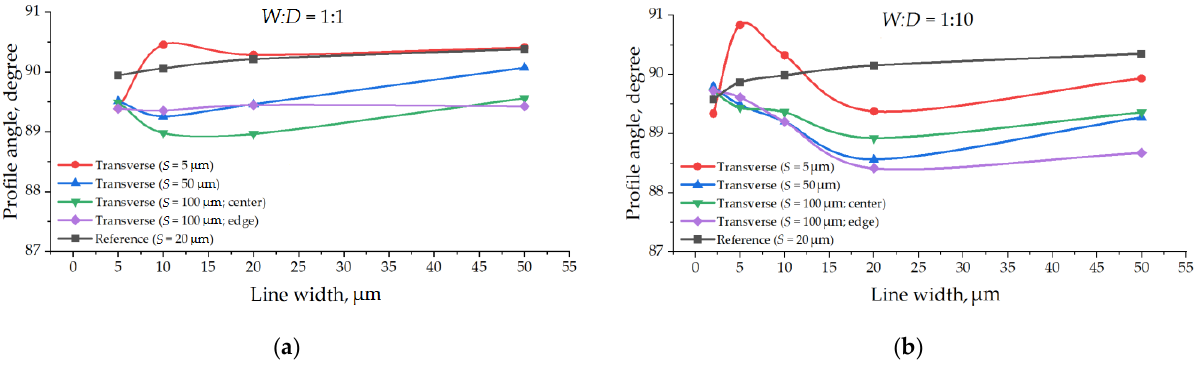
Figure 10. Profile angle depending on the target lines width: ( a ) For W:D = 1:1 aspect ratio; ( b ) For W:D = 1:10 aspect ratio.